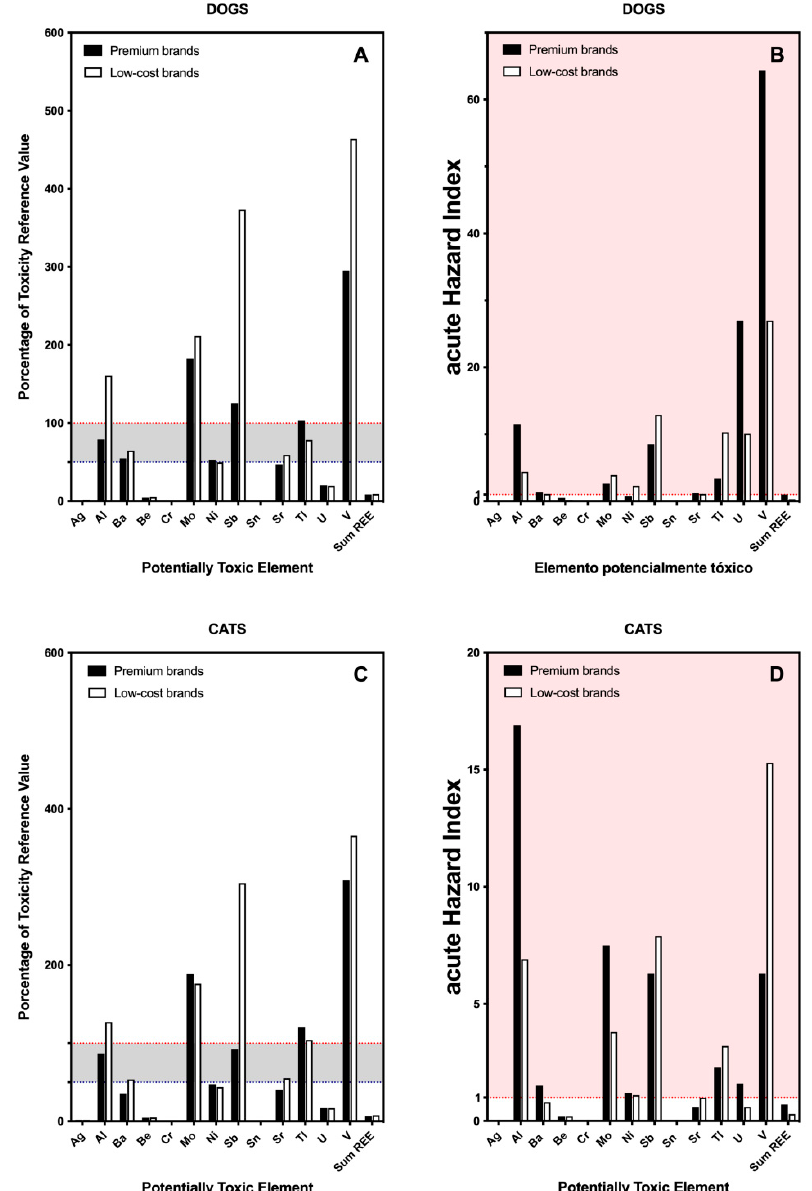
Figure 3. Bar plot indicating the percentage of the toxic reference value (TRV) and the acute Hazard Index (aHI) of potentially toxic elements and RREs, provided by the consumption of commercial dry food separated by the type of brand: premium vs. low-cost brands. ( A , B ) Results for dogs; ( C , D ) results for cats. Red dotted line indicates 100% of the TRV or the threshold for toxic effect, for each element. Abbreviations: Ag, silver; Al, aluminum; Ba, barium; Be, beryllium; Cr, chromium; Mo, molybdenum; Ni, nickel; Sb, antimony; Sn, tin; Sr, strontium; Tl, thallium; U, uranium; V, vanadium; Sum RRE, sum of cerium, dysprosium, erbium, europium, gallium, gadolinium, holmium, indium, lanthanide, lutetium, niobium, neodymium, praseodymium, samarium, tantalum, terbium, thulium, yttrium and ytterbium.